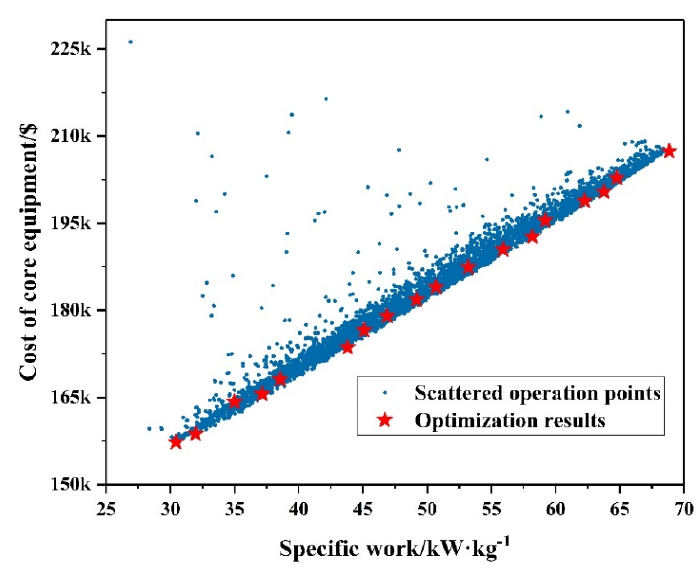
Figure 10. Optimization result of the simple recuperated cycle.